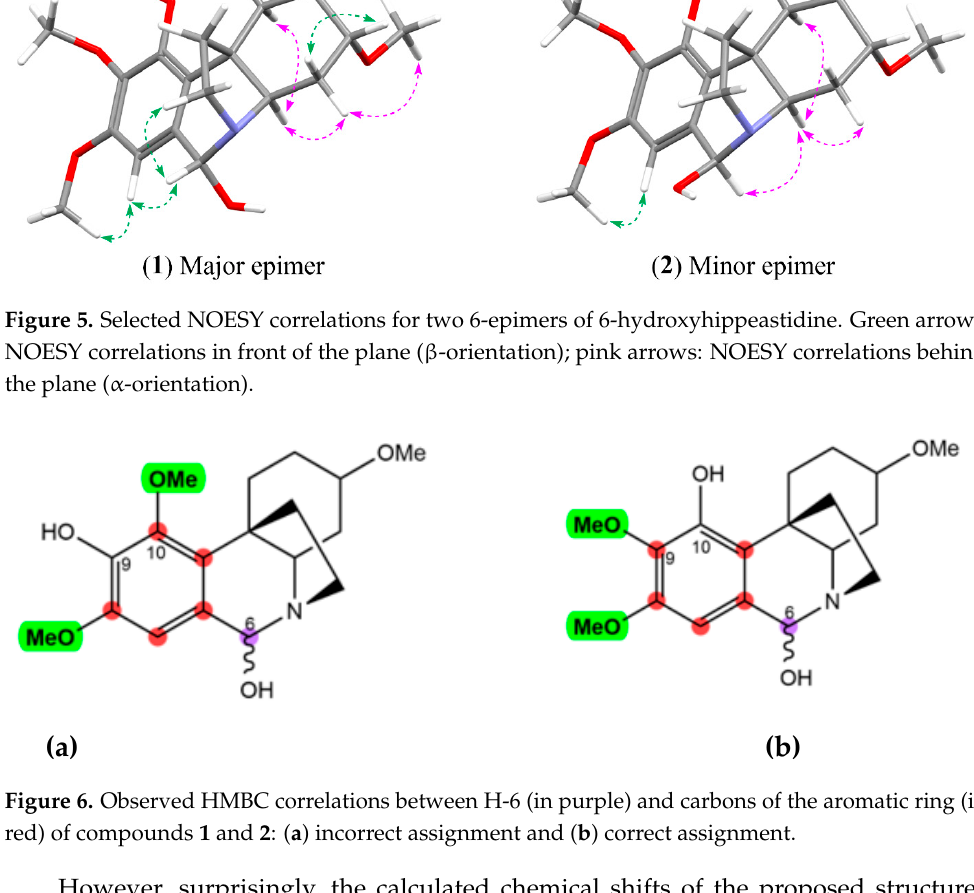
(in red) of compounds 1 and 2 : ( a ) incorrect assignment and ( b ) correct assignment. red) of compounds 1 and 2 : ( a ) incorrect assignment and ( b ) correct